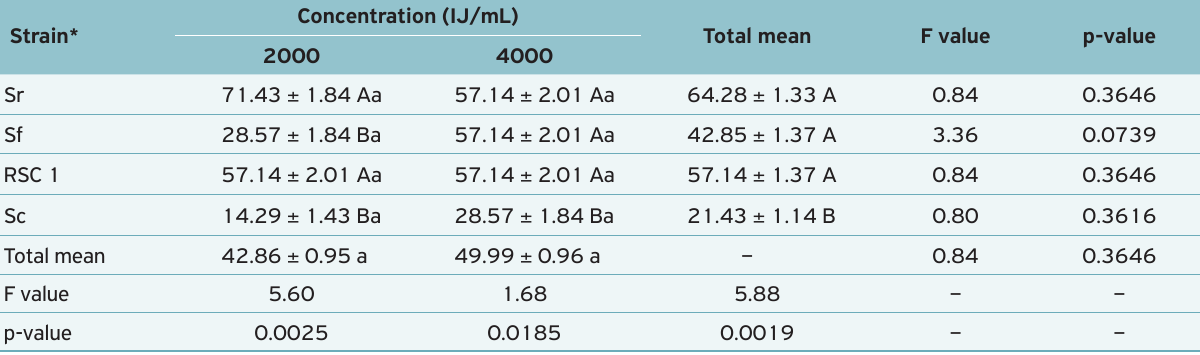
Table 1. Mortality ± standard error of Mahanarva spectabilis nymphs caused by strains of entomopathogenic nematodes applied at two concentrations, under greenhouse